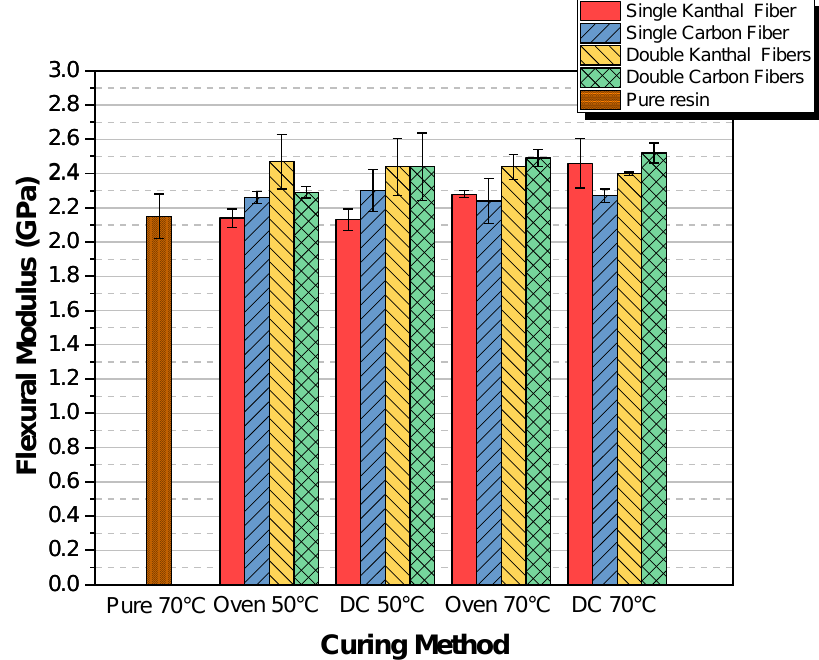
Figure 4. Flexural modulus versus curing method, for both types of fibers and for both single fiber and double fiber specimens.